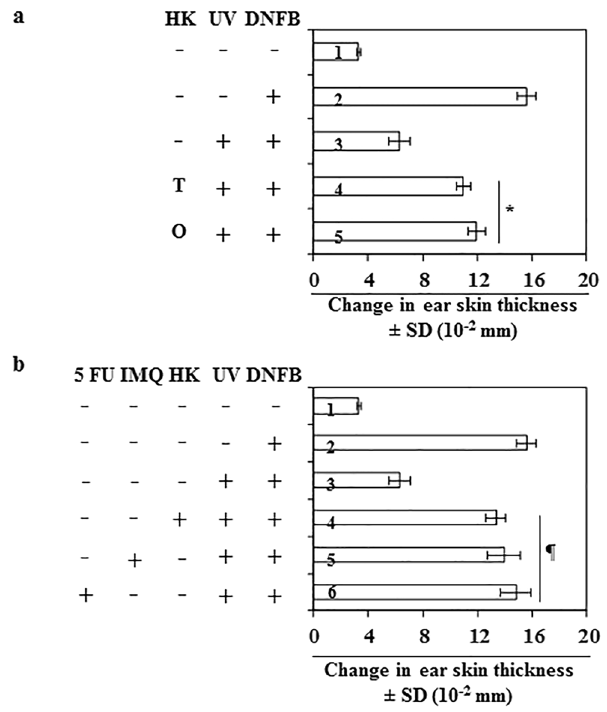
Figure 6. Comparative effect of honokiol (topical vs oral) and other anti-skin cancer drugs on UVB-induced suppression of the CHS response in C3H/HeN mice. The CHS protocol was followed as detailed under Fig. 1, n = 5/group. ( a ) Mice in group-4 were administered honokiol by topical application (2.0 mg/mouse) and the mice in group-5 were administered honokiol by oral gavage (2.0 mg/mouse) 30 min before each UVB irradiation. The CHS response was measured. Significant increase in CHS response (groups 4 and 5) versus UVB exposure in the absence of honokiol treatment (group-3). * P < 0.001. T, topical treatment of honokiol; O, treatment of honokiol by oral gavage. ( b ) Comparative effects of equimolar concentrations of honokiol, imiquimod and 5-fluorouracil on the UVB-induced suppression of the CHS response. The CHS protocol used was identical to that described for panel ( a ). Mice in groups 4, 5 and 6 were treated topically with honokiol, imiquimod or 5-fluorouracil in equimolar concentration (18.8 mM) 30 min before each UVB exposure. Significant difference in CHS response versus UVB exposure in the absence of any agent treatment (group-3), ¶ P < 0.001, n = 4 per